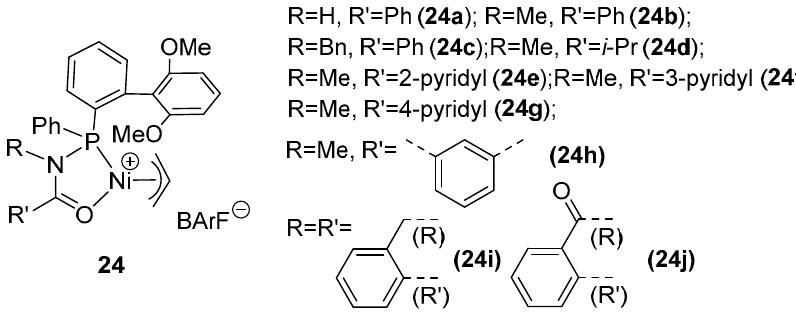
Figure 20. The N -bridged phosphine carbonyl Ni catalysts 23a – e bearing five- to eight-membered-ring.